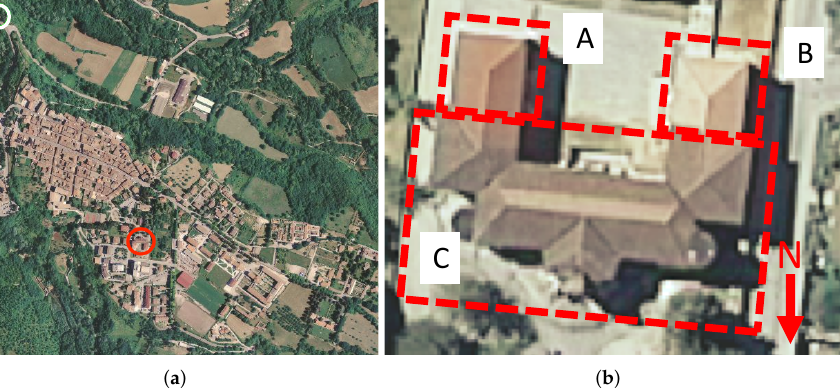
Figure 1. ( a ) Aerial view of Amatrice before the 2016 earthquake: location of the aggregate studied in this paper (red circle) and of the strong motion accelerometric station AMT (white circle). ( b ) Aerial view of the buildings belonging to the